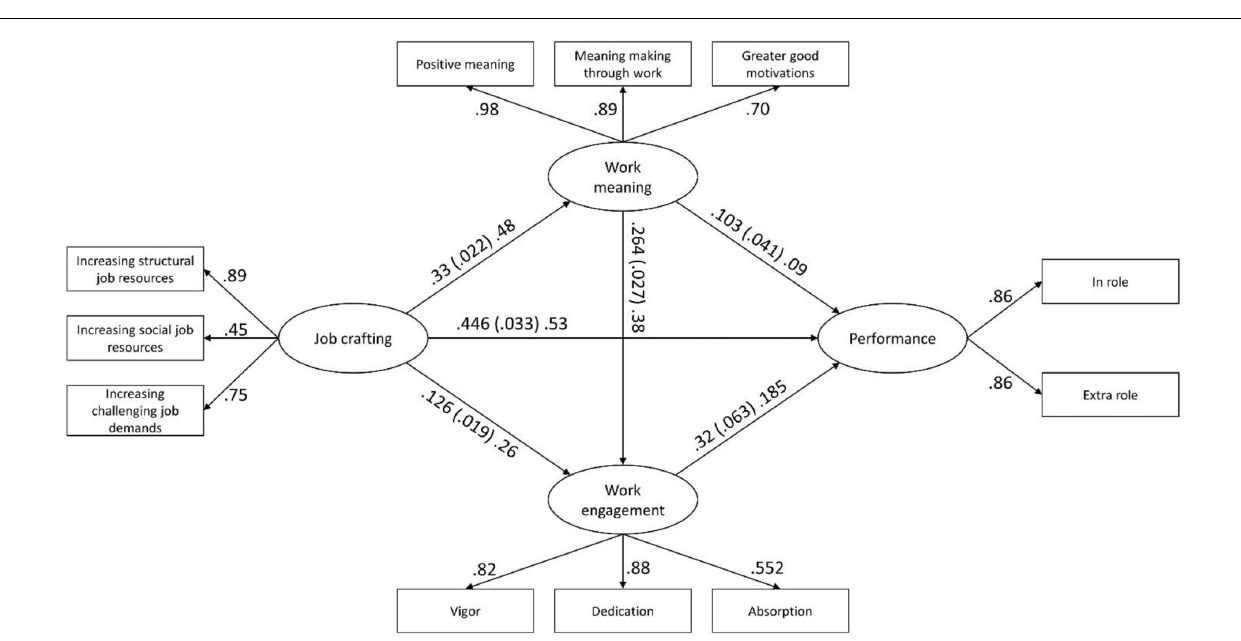
FIGURE 2 | Results of the proposed research model. Estimates are reported as “unstandardized (standard error) standardized” and “standardized.” All reported coefficients and factor loadings were significant ( <